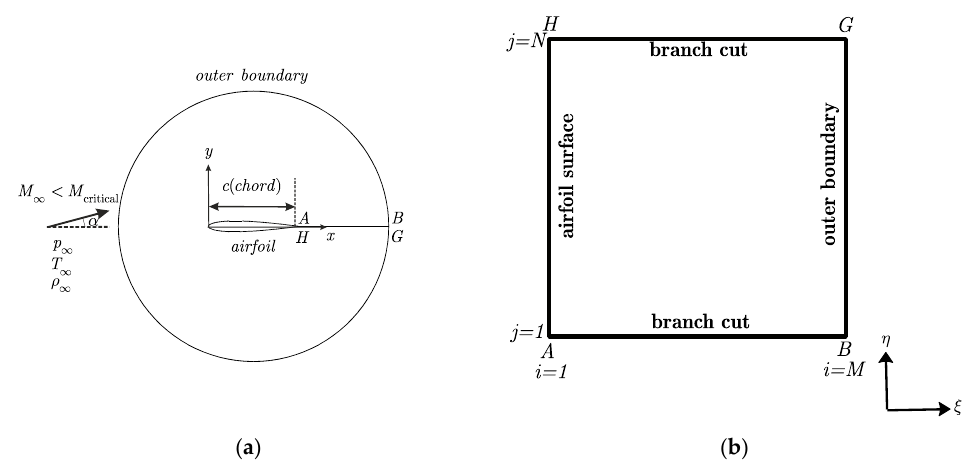
Figure 1. The physical and the computational domains. ( a ) Physical domain. ( b ) Computational Figure1. Thephysicalandthecomputationaldomains. ( a )Physicaldomain. ( b domain.